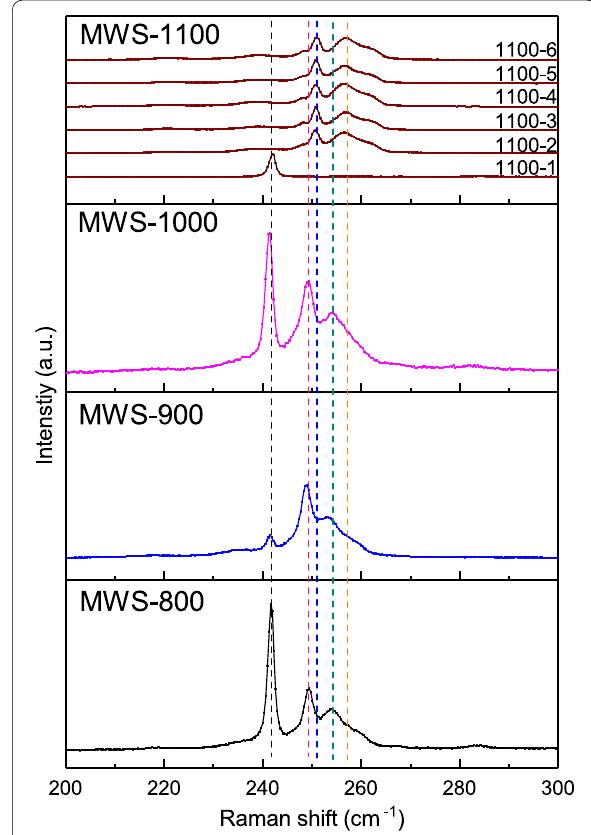
Fig. 4 It is 242 cm − 1 (MoSe 2 , A 1g , black dash line), 251 cm − 1 (WSe 2 , A 1g , blue dash line) and 257 cm − 1 (WSe 2 , 2LA (M), orange dash line) in the Raman spectra. The 249 cm − 1 (WSe 2 , A 1g , red dash line) and 254 cm − 1 (WSe 2 , 2LA (M), green dash line) are the red shift of the